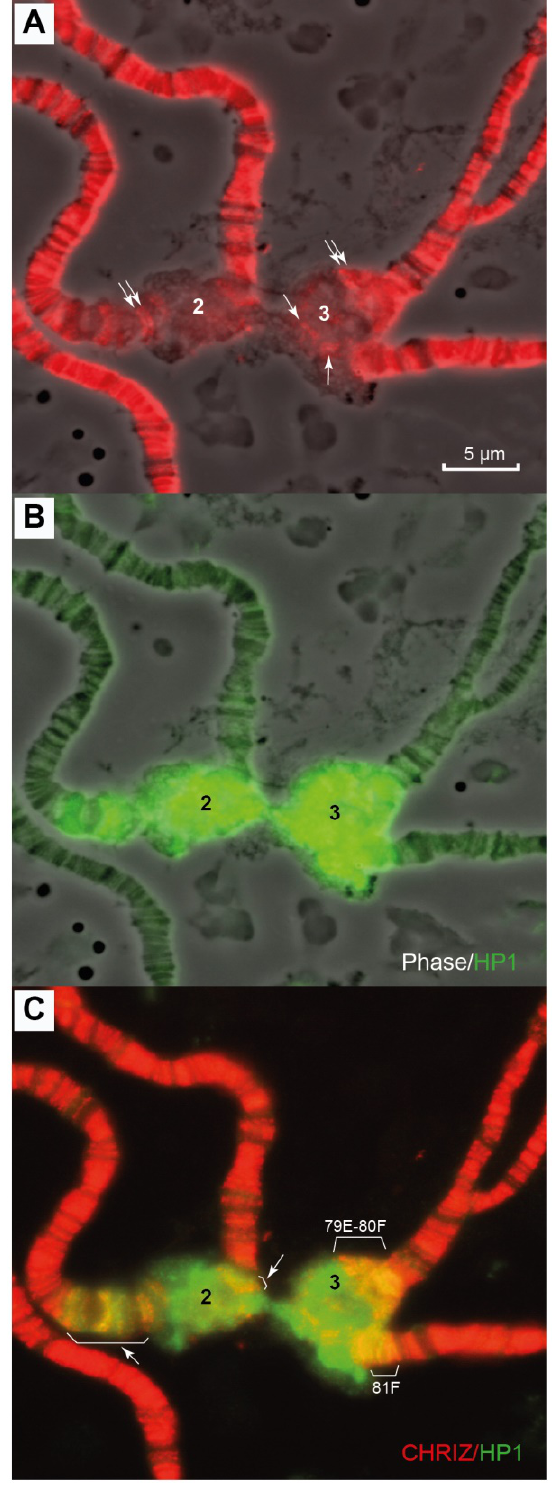
Figure 12. Immunolocalization of the HP1 protein in a polytene chromosome of D. melanogaster . ( A ) Localization of antibodies to the CHRIZ protein; ( B ) localization of antibodies to the НР 1 protein; ( C ) localization of antibodies to the НР 1 and CHRIZ proteins. The genotypes in all figure parts is Rif11. The numbers 2 and 3 designate heterochromatin regions in chromosomes 2 and 3, respectively. HP1 is stained in green. Sites of co-localization with CHRIZ are stained in yellow in 79E-80F, 81F and small islets in heterochromatin. Scale bar value is the same for every figure.